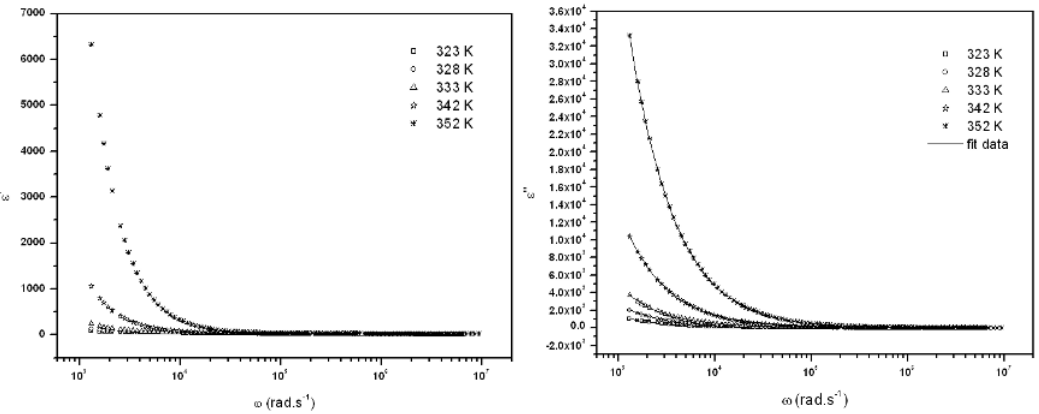
Fig.9. Frequency dependence of the real part ( ε ’) and the imaginary part permittivity ( ε ”) with the best fitted